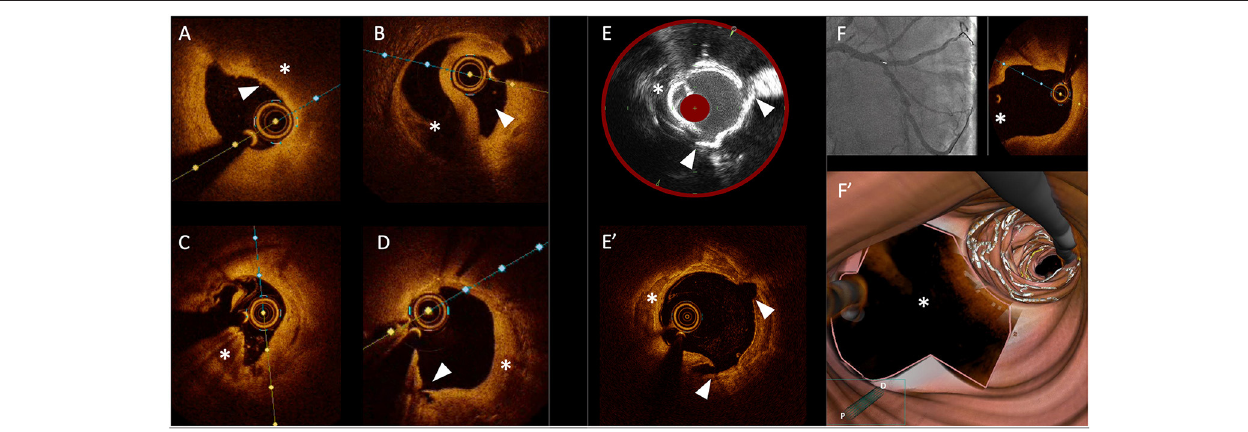
FIGURE 1 | Gallery of images obtained with different intracoronary imaging tools. (A) OCT cross section showing a coronary plaque at high-risk of rupture with a thin-cap (arrow head) covering a lipid-rich atheroma. (B) OCT cross section showing a coronary dissection with a clear distinction of the true lumen (arrow head) and the false lumen (asterisk). (C) OCT cross section showing a calcified nodule (asterisk). (D) OCT cross section showing in-stent neointimal growth (asterisk) causing re-stenosis; the arrow head shows a small intimal dissection. (E) Optimal correspondence between images obtained with IVUS/NIRS (E) and OCT (E’) showing a cracked calcific plaque after treatment with intravascular lithotripsy (with arrow heads showing corresponding cleavage planes and asterisks showing a calcific plaque). (F) OCT pullback showing a precise ostial stent implantation with no stent struts protruding into the main vessel (asterisks) including 3D reconstruction of the bifurcation site (F’)